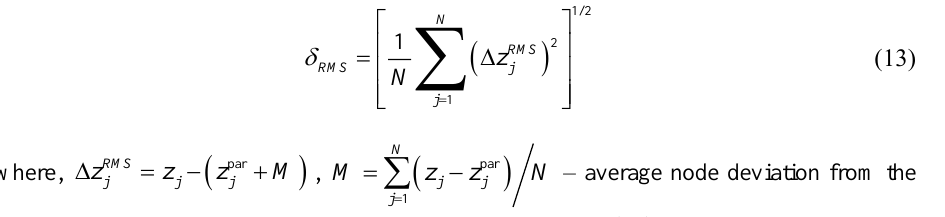
– average node deviation from